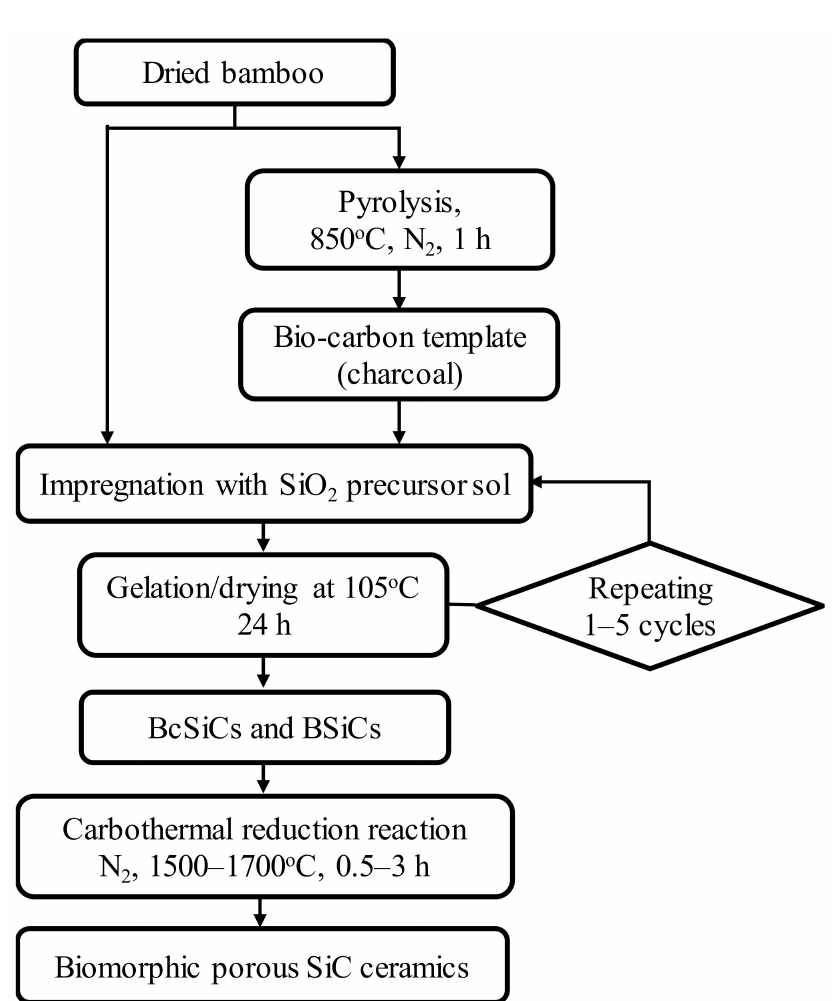
Figure 1. Processing scheme for manufacturing silicon carbide (SiC) ceramics with a biomorphic pore structure from bamboo by combining sol–gel impregnation and carbothermal